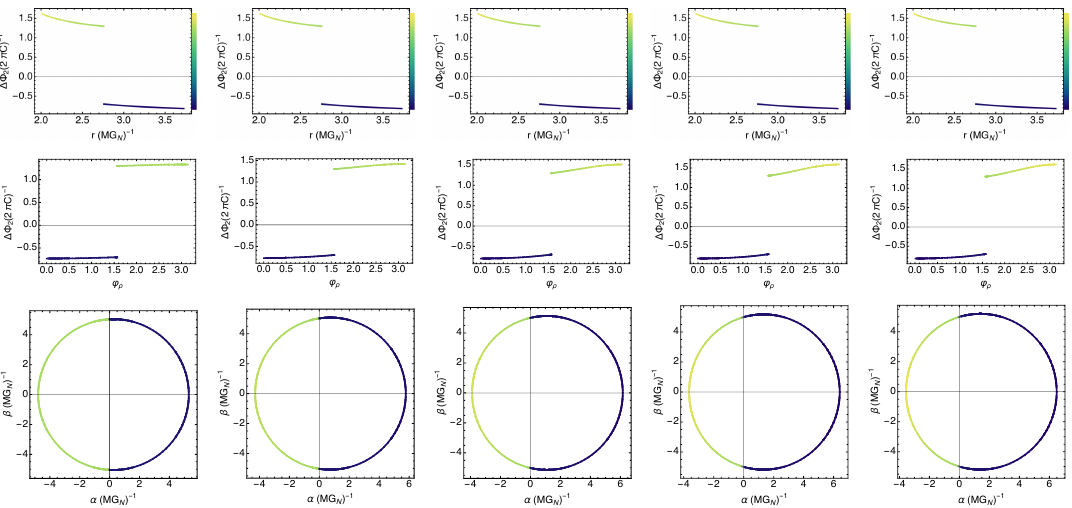
Figure 3 . The same kinds of plots as in figure 2, now for a fixed black hole spin parameter a ( MG N ) − 1 = 0 . 7 and for various observer inclinations θ o . From left to right: θ o = 10 ◦ , θ o = 30 ◦ , θ o = 50 ◦ , θ o = 70 ◦ , θ o = 90 ◦ . See caption of figure 2 for